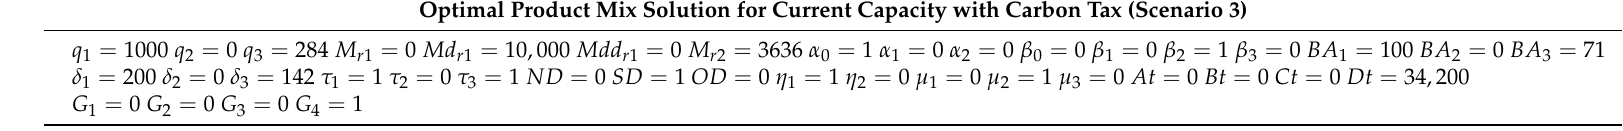
Table 5. Optimal solution for current capacity with carbon tax (Scenario 3).